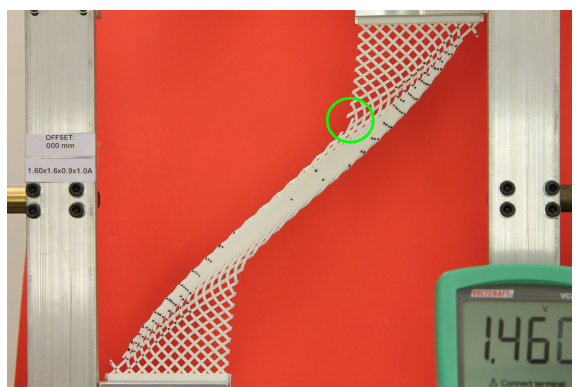
Figure 13. Deformed sample C directly after first failure occurs, region marked by the